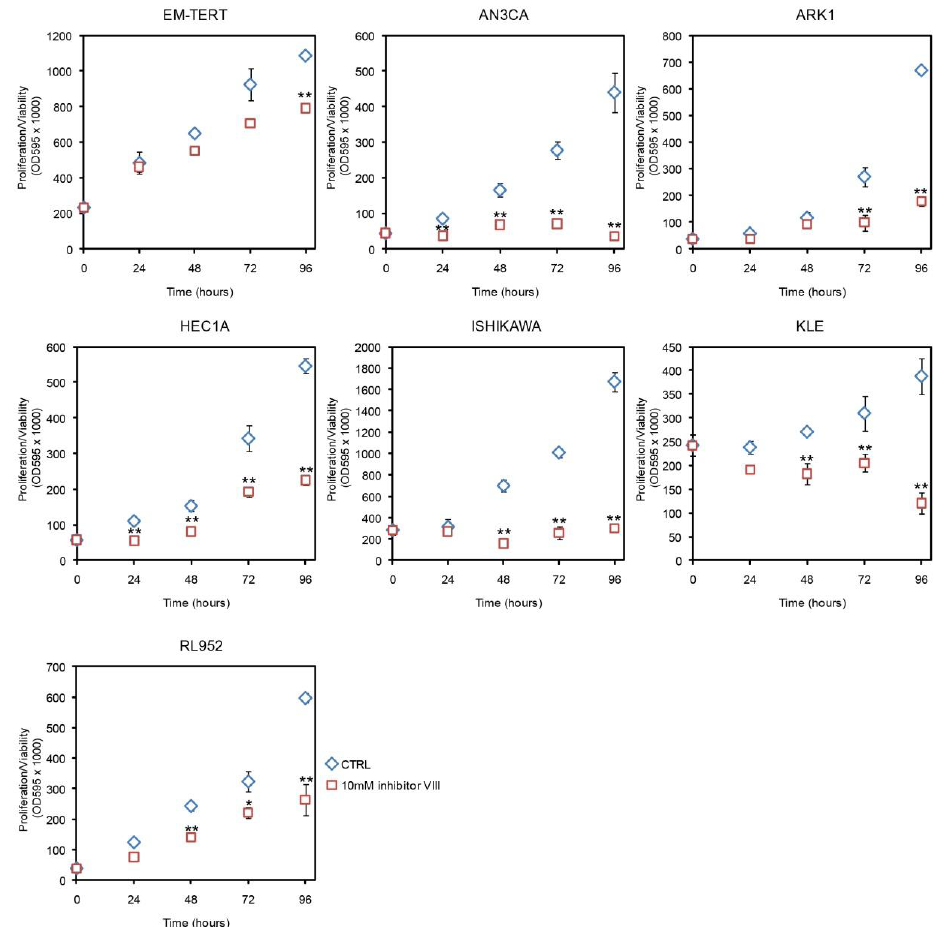
Figure 2. Effects of GSK3β inhibitor VIII measured by MTT. GSK3β inhibitor VIII had a modest effect on EM-TERT cells, whereas cell proliferation/viability was substantially reduced in cancer cell lines. * p < 0.05; ** p <